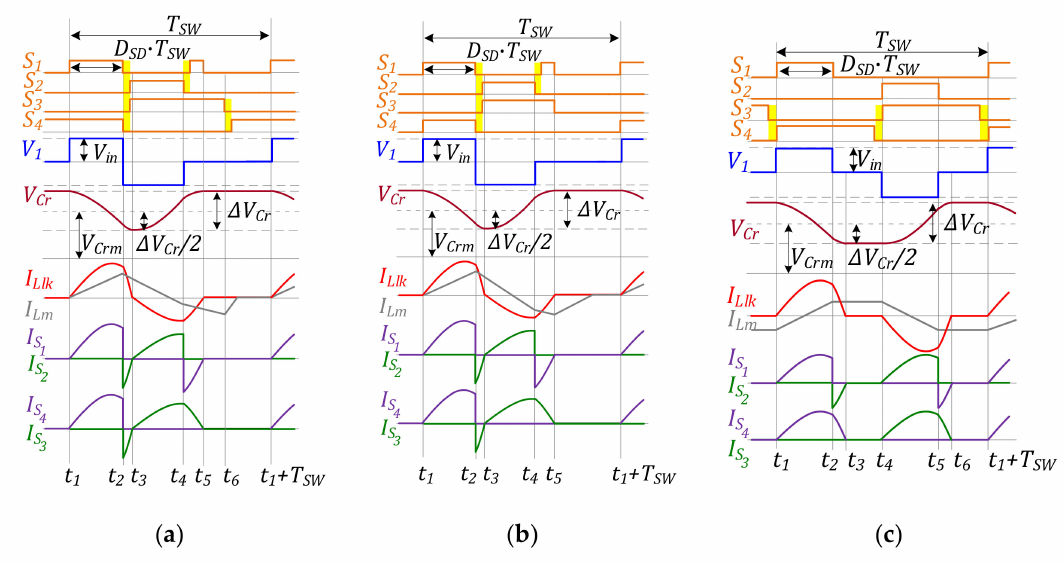
Figure 4. SRC operation with the proposed HSPWM ( a ), ISPWN ( b ) and HPWM ( c )